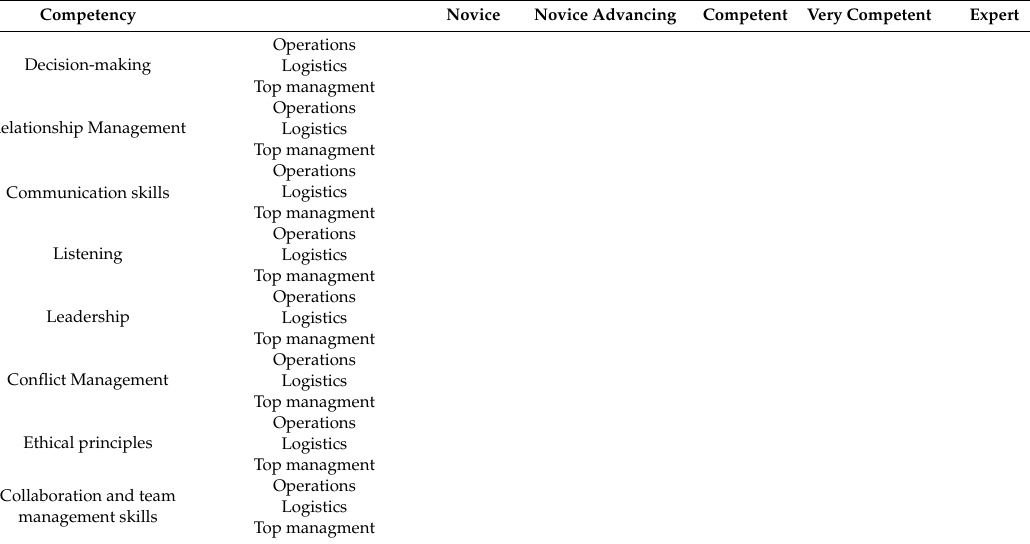
Table A2. Development of competencies